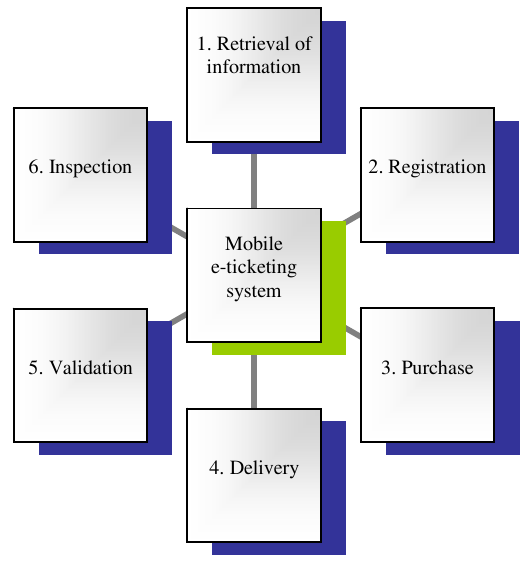
Fig 5. Functional areas of mobile e-ticketing system